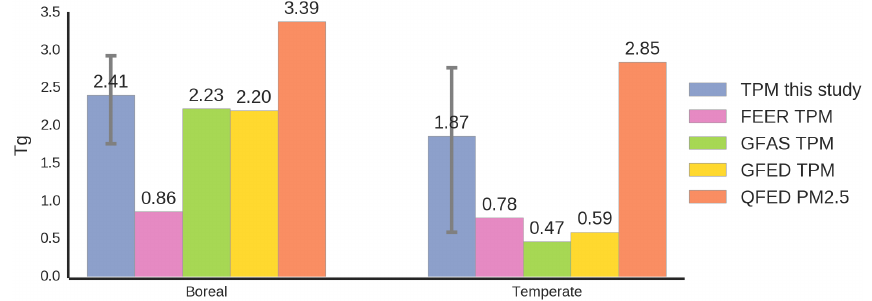
Figure 7. Total TPM emissions derived in this study and estimates for the same events and days of emission given by other methods. Error bars represent a 95% confidence interval, taking into account uncertainties in (i) AERONET retrievals, (ii) inferred water fraction, (iii) particle density, (iv) modelled B ext and (v) estimated error in attributed daily